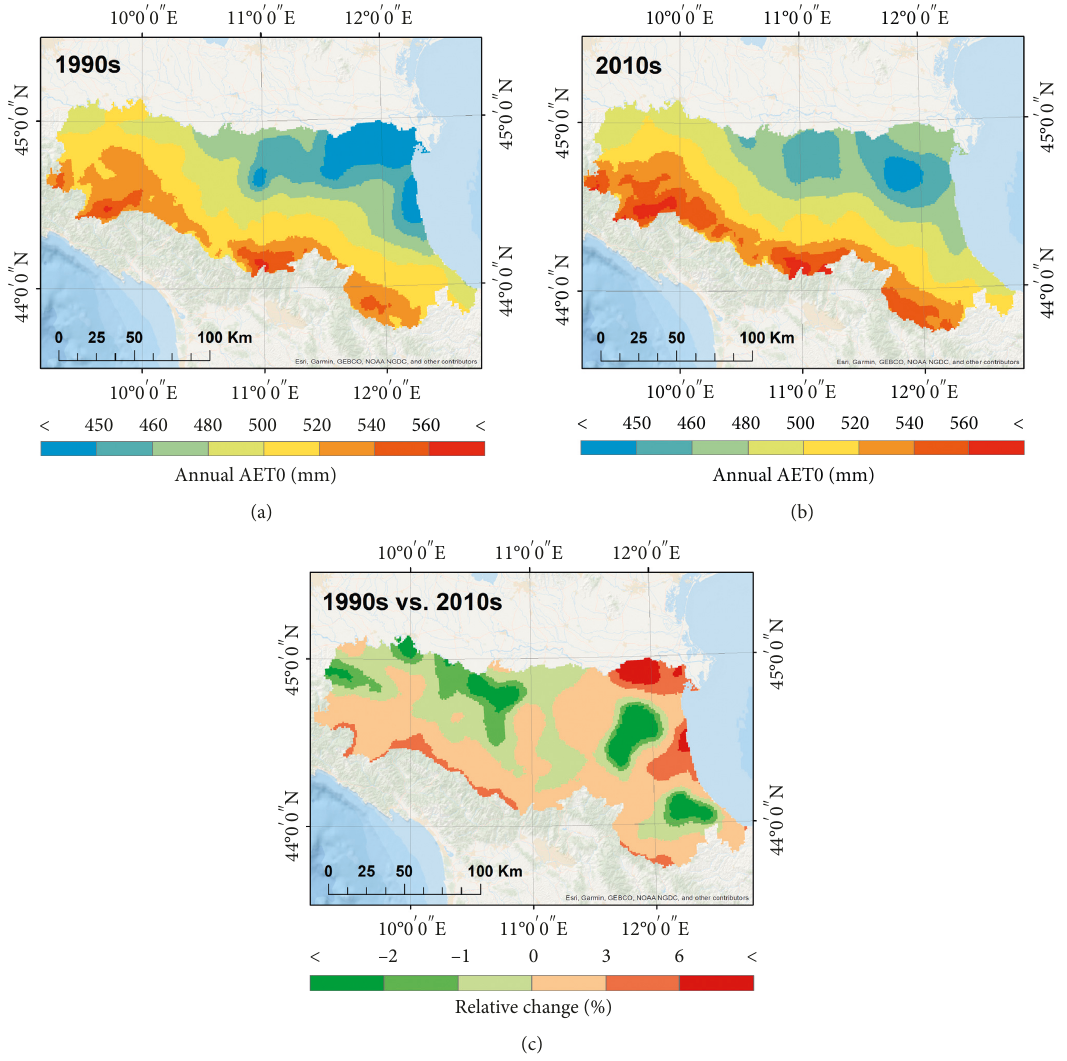
Figure 5: Spatial distribution of mean annual AET0. (a) The average of mean annual AET0 between 1961 and 1990. (b) The average of mean annual AET0 between 1991 and 2015. (c) The relative changes in mean annual AET0 as a difference between the two time-periods. Background image source: Esri, Garmin, GEBCO, NOAA NGDC, and other